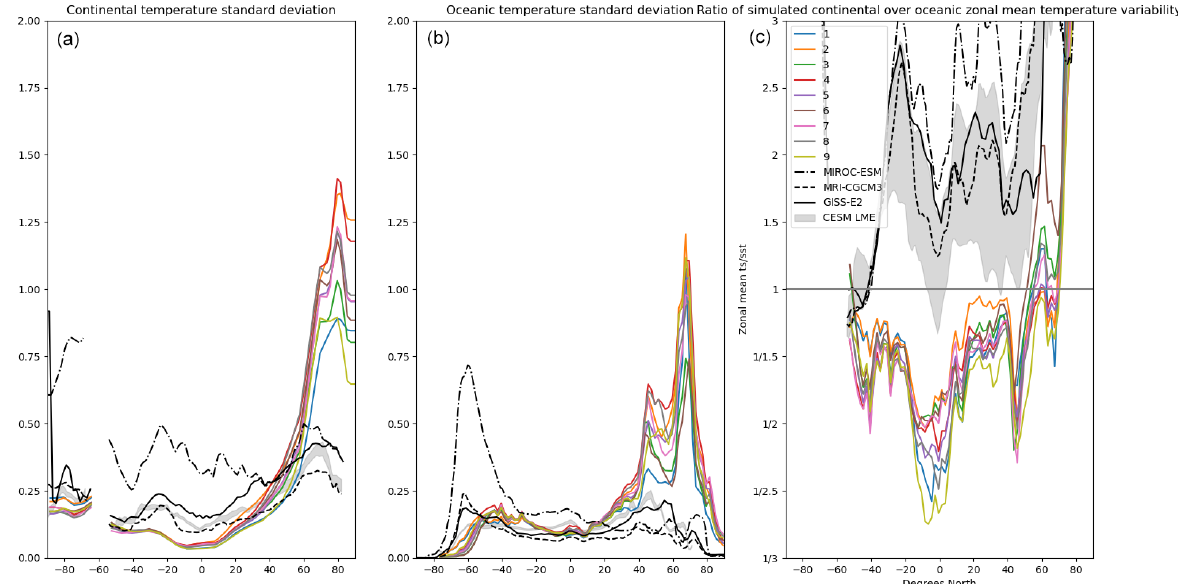
Figure A8. Simulated zonally averaged contrast in land–ocean temperature variability as a function of latitude. Depicted are continental variability (a) , ocean variability (b) and the ratio of continental over ocean variability (c) . SSTs are used to calculate ocean temperature variability. Results are shown for the nine-member perturbed-parameter i LOVECLIM ensemble (colours) and for three different CMIP5 simulations for the last 1000 years. Grey shading shows the 1 σ range of all CESM ensemble members. Note that the y -axis scale in (c) is non-linear, with for instance 1 / 1 . 5 or 1 / 2, meaning that there is 50% or 100% more variability over the ocean than there is over the continents.